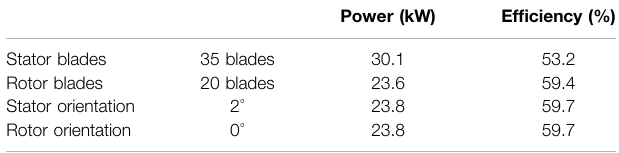
TABLE 4 | Stator and rotor optimized values.